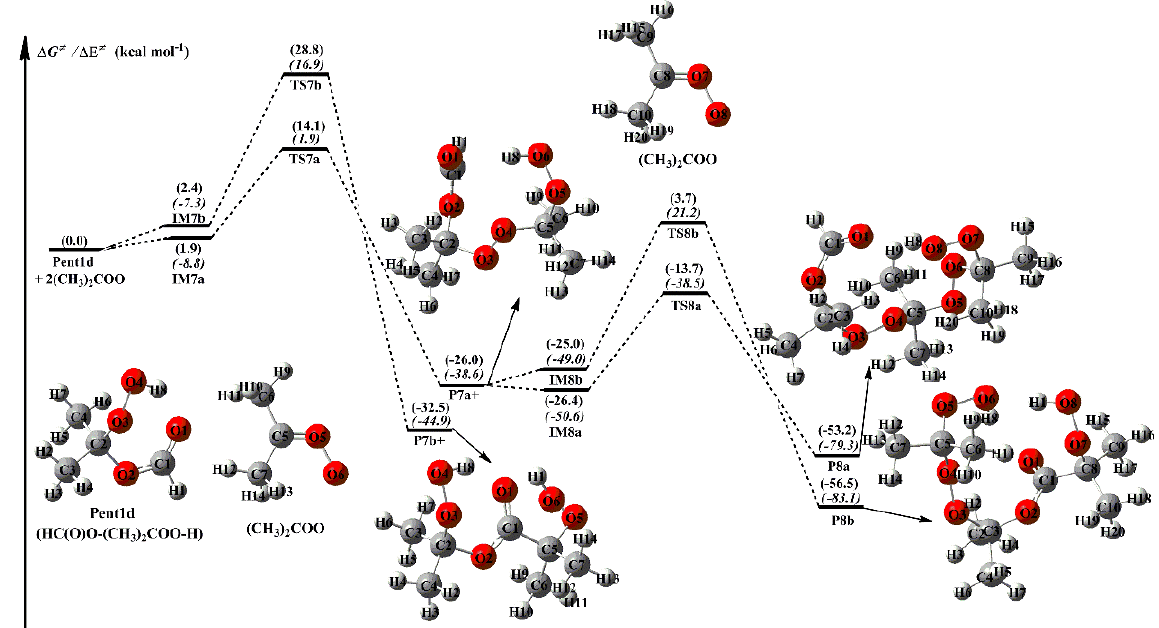
Figure 5. PES ( (cid:49)G and (cid:49)E ) for the 2(CH 3 ) 2 COO + Pent1d reaction at the M06-2X/ma-TZVP//M06-2X/6-311 + G(2df,2p) level of